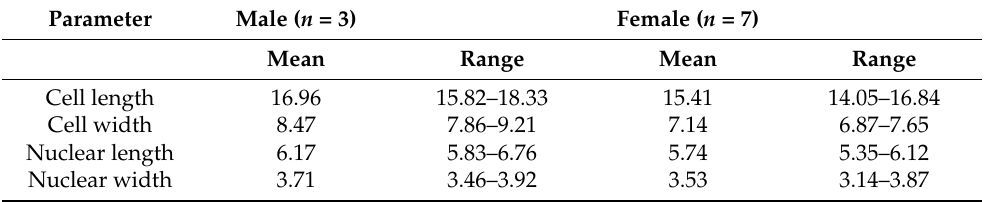
Table 1. Erythrocyte parameters of both the male and female false gharial. For each parameter, the mean ( µ m) and range ( µ m) of erythrocyte cells ( n = 10) and nucleus size are reported.